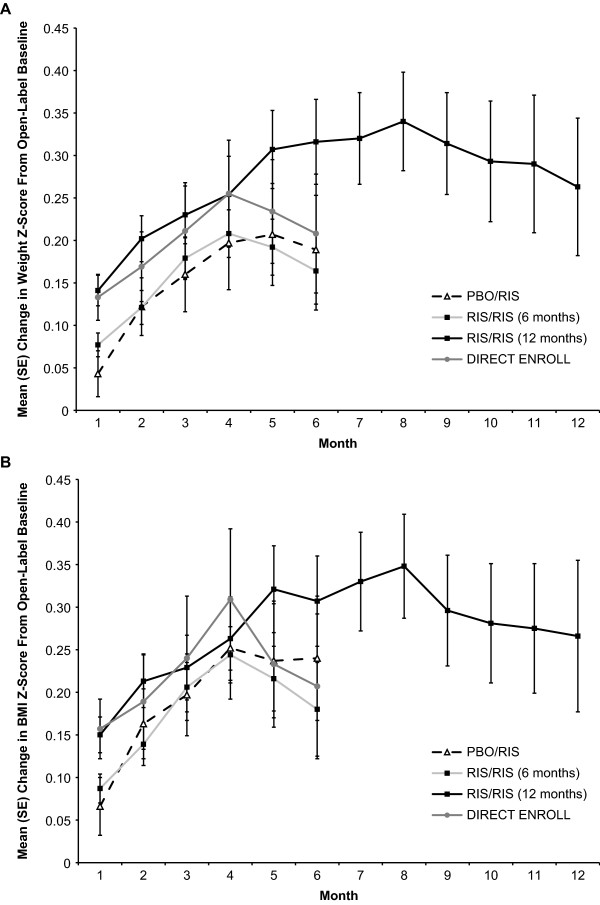
Mean change inzscores for body weight (A) and body mass index (B) over the course of the study for the PBO/RIS group, RIS/RIS group, and all subjects. Data are presented for all subjects to the 6- or 12-month end point. The RIS/RIS 6- and 12-month groups are mutually exclusive